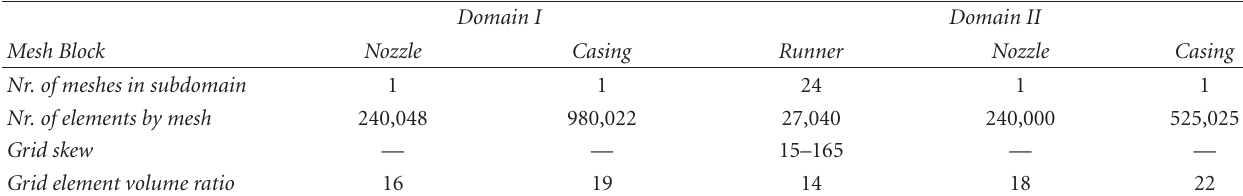
Table 2: Number of elements and characteristics of